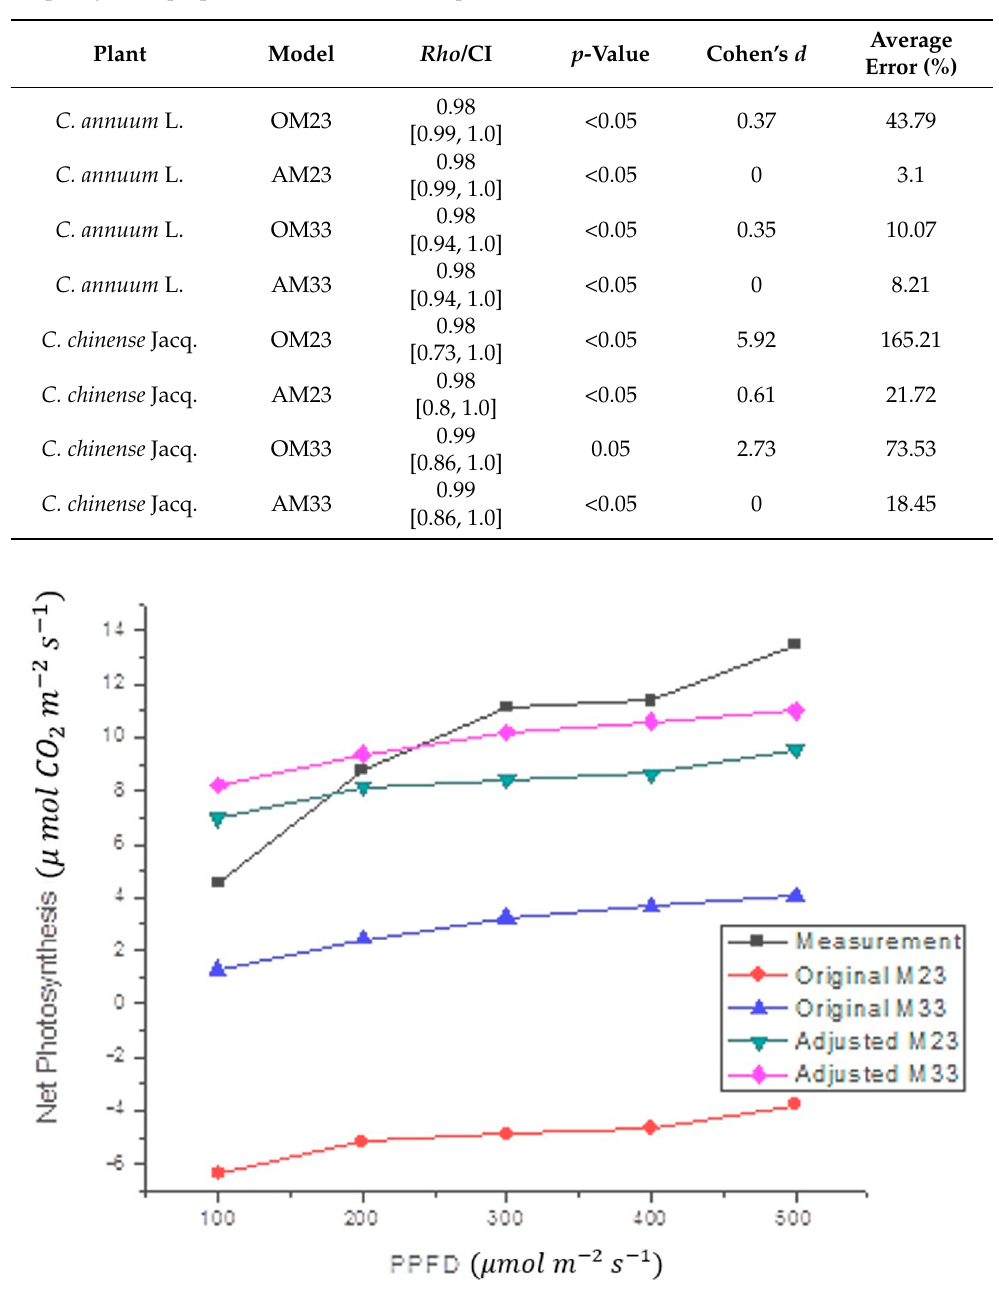
Figure 7. Comparison between the average of NP estimate in Capsicum chinense Jacq., at 29.8 ◦ C, and the proposed mathematical model at different air temperatures (M23 and M33). Original models use O a1 , while fitted models include O a2 , Equation (4).